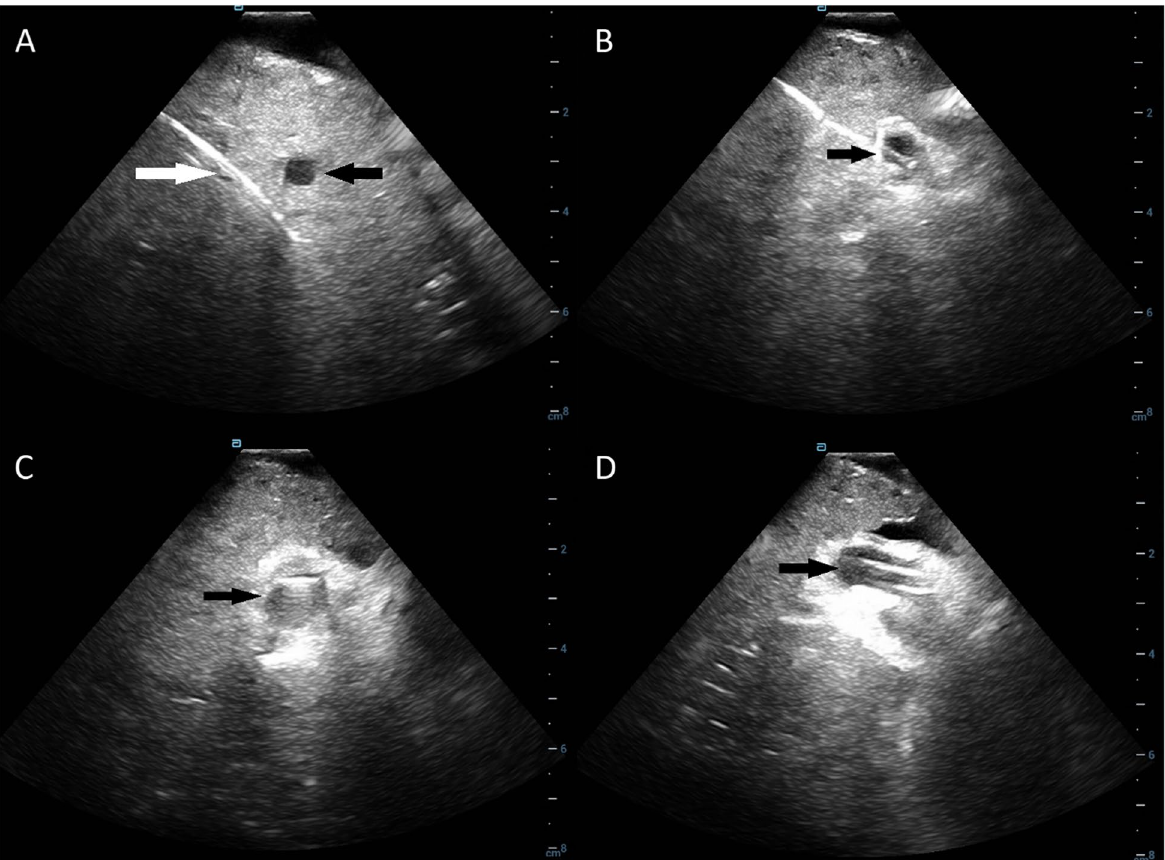
Fig. 3 Portal Vein Access Under Intracardiac Echocardiography (ICE) Guidance. A US visualization of right hepatic vein catheterization (white arrow) with adjacent right portal vein (black arrow). B Advancement of the ICE catheter into the right portal vein (black arrow). C TIPS needle tip (black arrow) in the portal vein. D Advancement of the TIPS introducer sheath into the portal vein (black arrow)